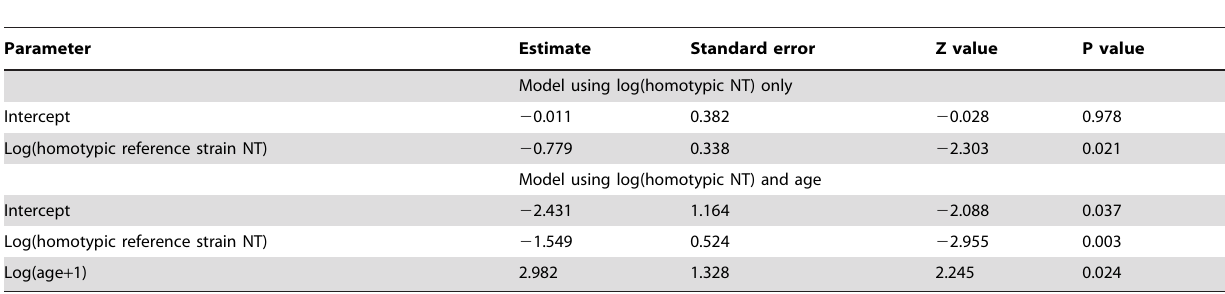
Table 2. Logistic regression analysis of the relationship between homotypic neutralizing antibody titers and dengue PCR status. a